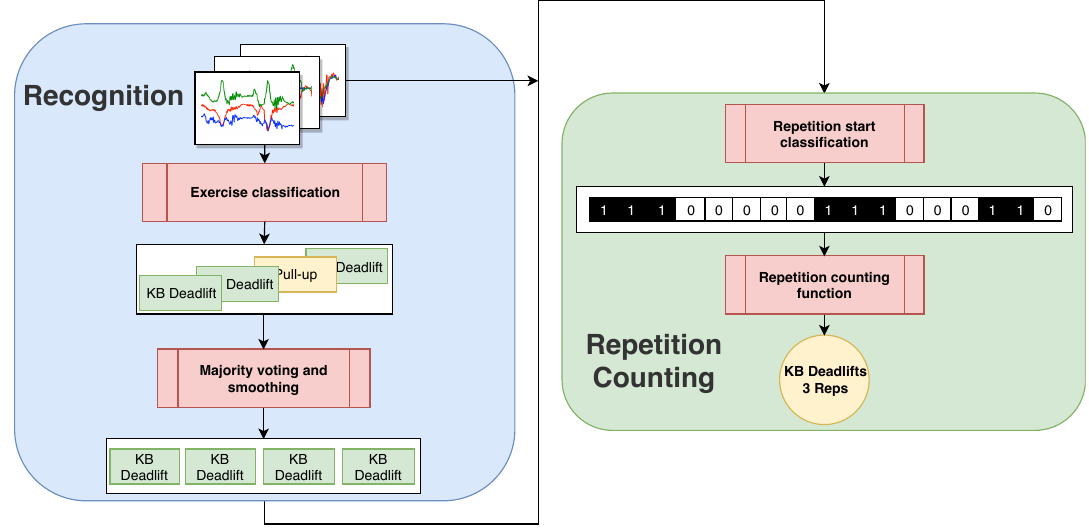
Figure 4. System pipeline. For exercise recognition, raw sensor data is split up into windows and fed to a CNN that performs exercise classification. For repetition counting, the windowed raw sensor data is fed into the repetition counting CNN, which corresponds to the exercise that was previously detected by the recognition